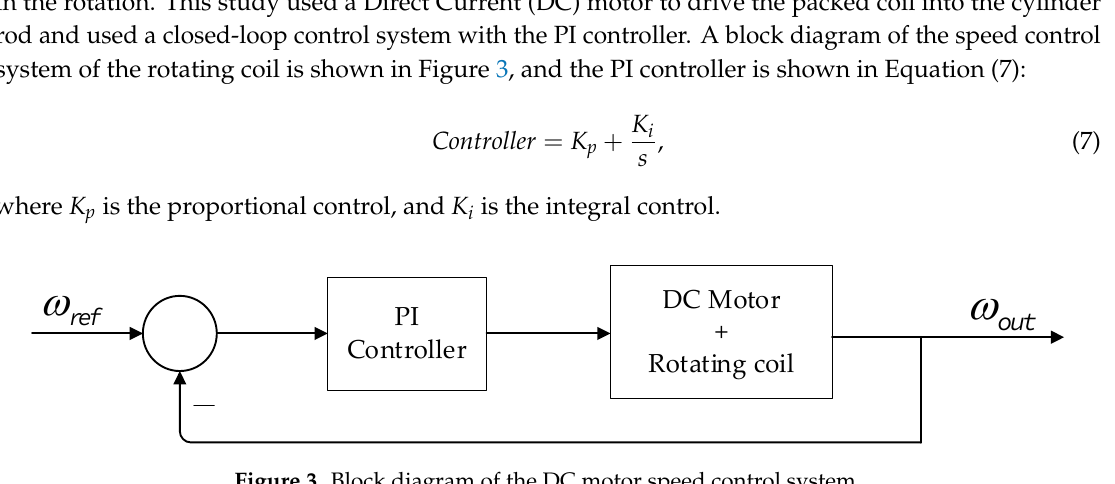
Figure 3. Block diagram of the DC motor speed control system.